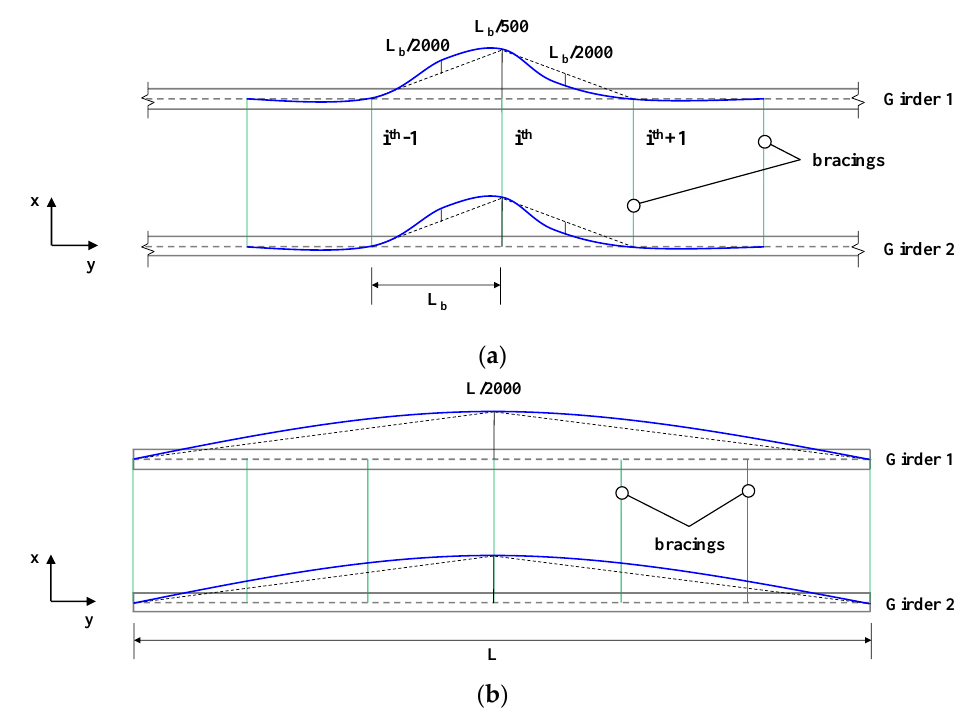
Figure 4. Initial imperfections for FEA: ( a ) initial imperfection of target segments and ( b ) initial imperfection of the girders for global LTB mode.